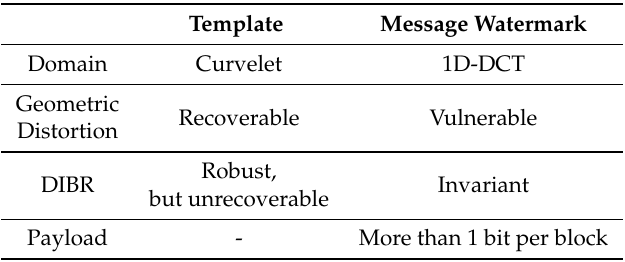
Table 3. The roles of templates and message